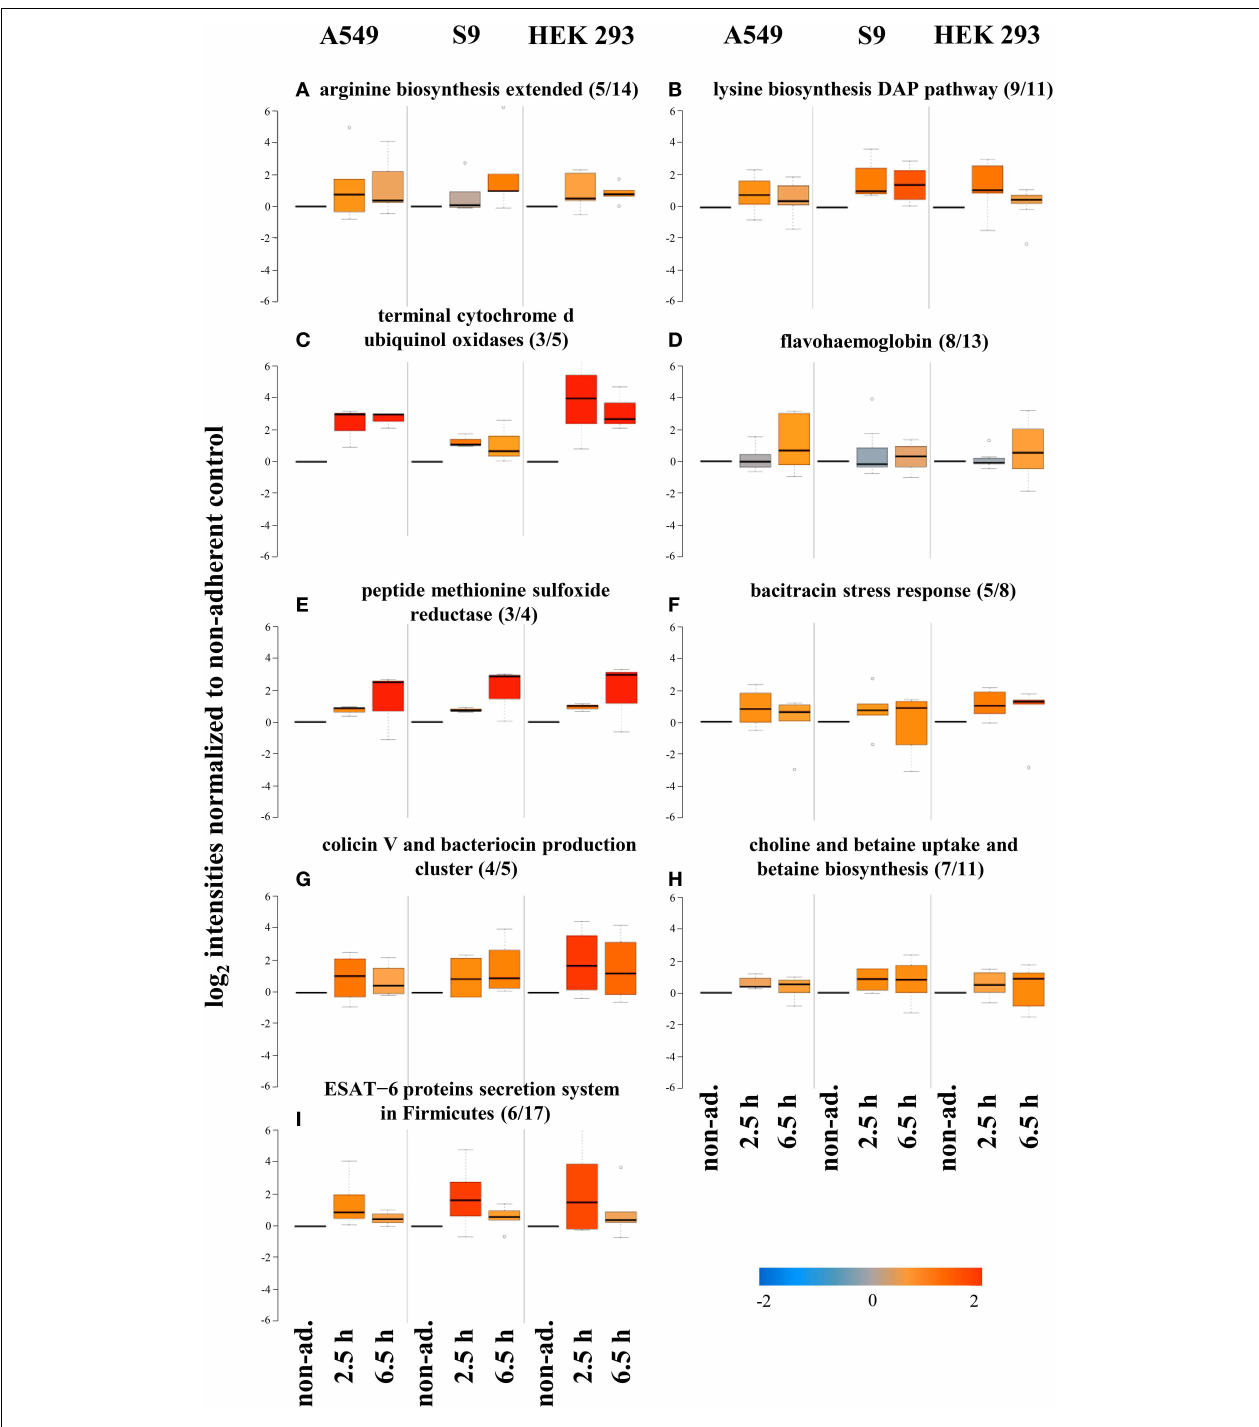
response to internalization compared to the non-adherent control. (A,B) Proteins involved in synthesis of arginine and lysine, (C) terminal oxidases, (D) flavohaemoglobins, and (E) methionine sulfoxide reductase, (F) bacitracin stress response, (G) colicin V and bacteriocin production, (H) choline and betaine uptake, and (I) the ESAT-6 secretion